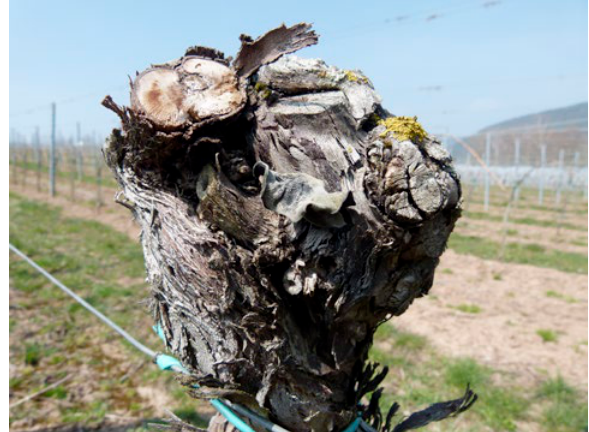
Figure 1. A dry-looking but still sporulating specimen of Auricularia auricula-judae on a dead grapevine; appearance of fruitbody was in late winter. Photograph: M.